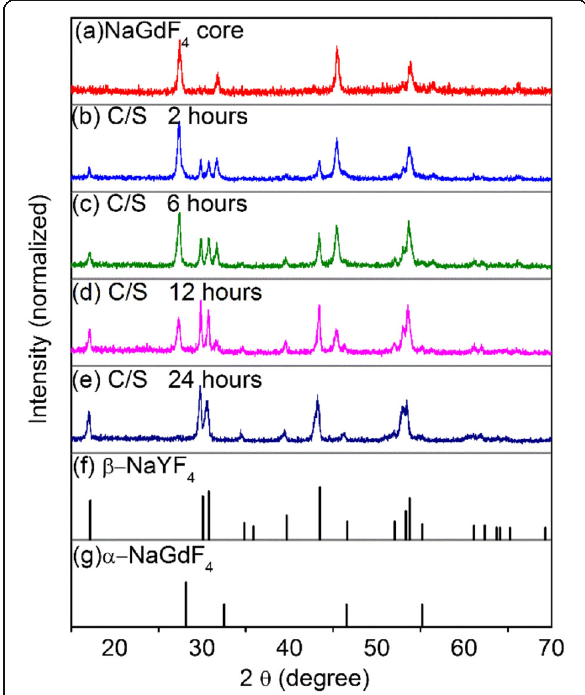
Fig. 2 XRD patterns of ( a ) the NaGdF 4 core nanocrystals, and the NaGdF 4 / NaYF 4 :Yb,Er core/shell (named C/S in the figure) nanocrystals with different reaction time, ( b ) 2 h, ( c ) 6 h, ( d ) 12 h, and ( e ) 24 h. ( f ) Standard data of β -NaYF 4 (JCPDS 16-334). ( g ) Standard data of α